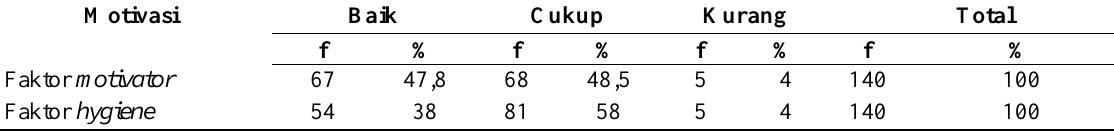
Tabel 4. Distribusi frekuensi motivasi perawat pelaksana